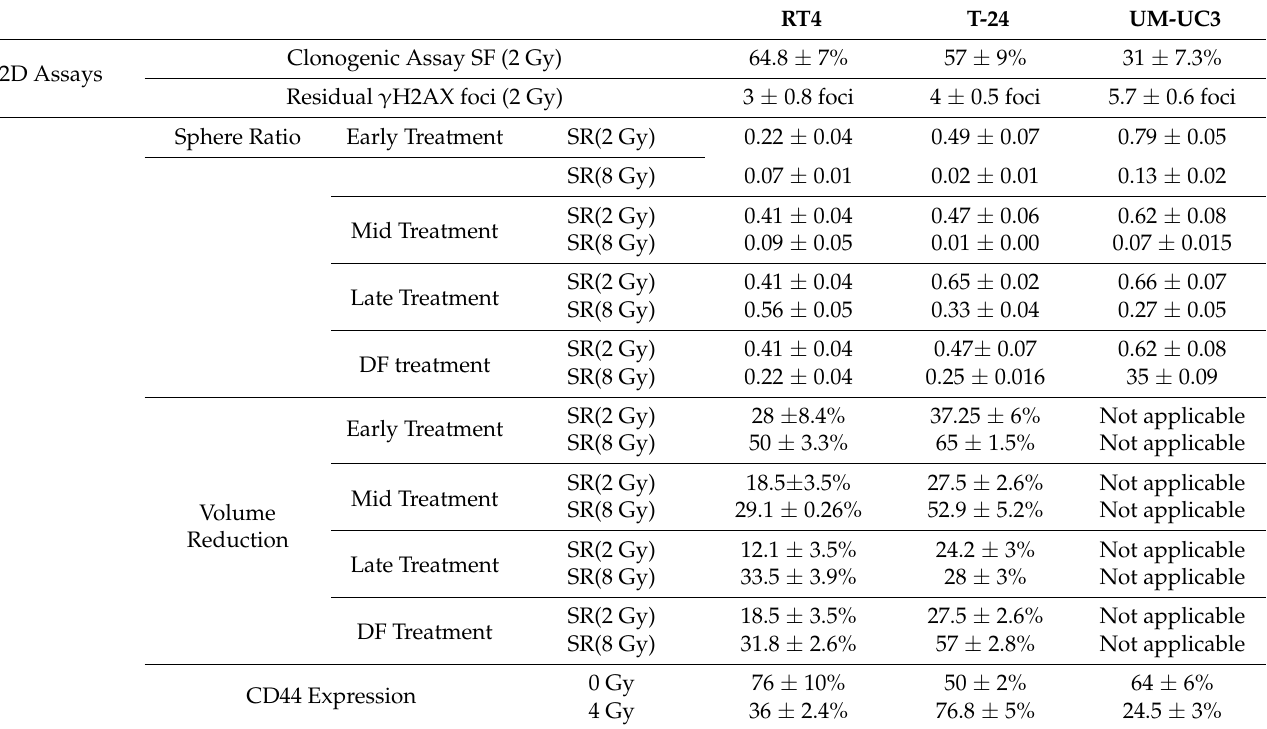
Table 5. Summary of all the results. For treatments where many doses where used, only the results after 2 Gy and 8 Gy are shown